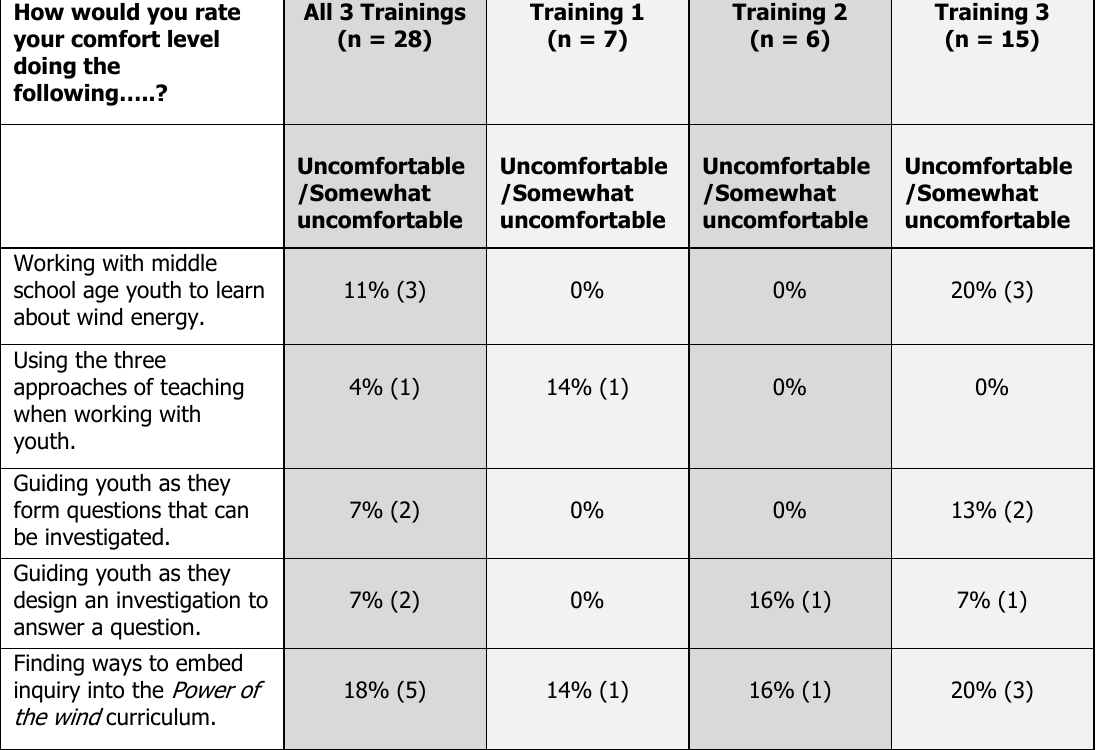
Adult Facilitators “Not Comfortable” with Essential